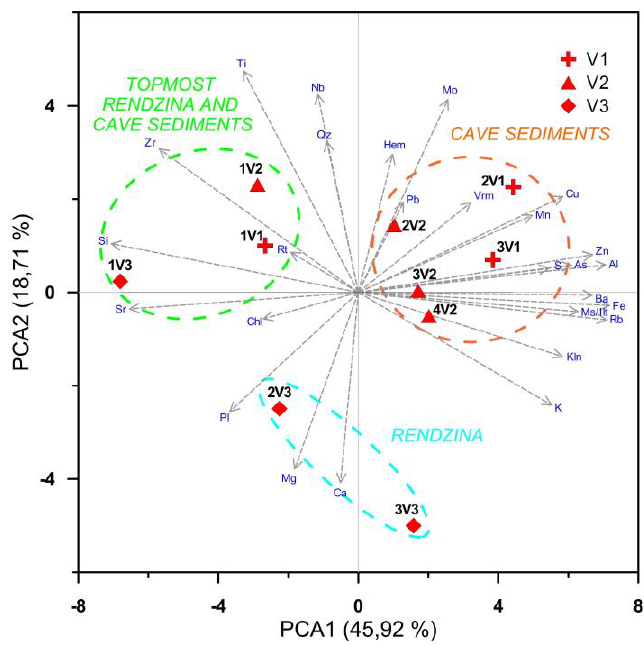
Figure 16. PCA (Principal Component Analysis) diagram for the overall XRF and XRD datasets.